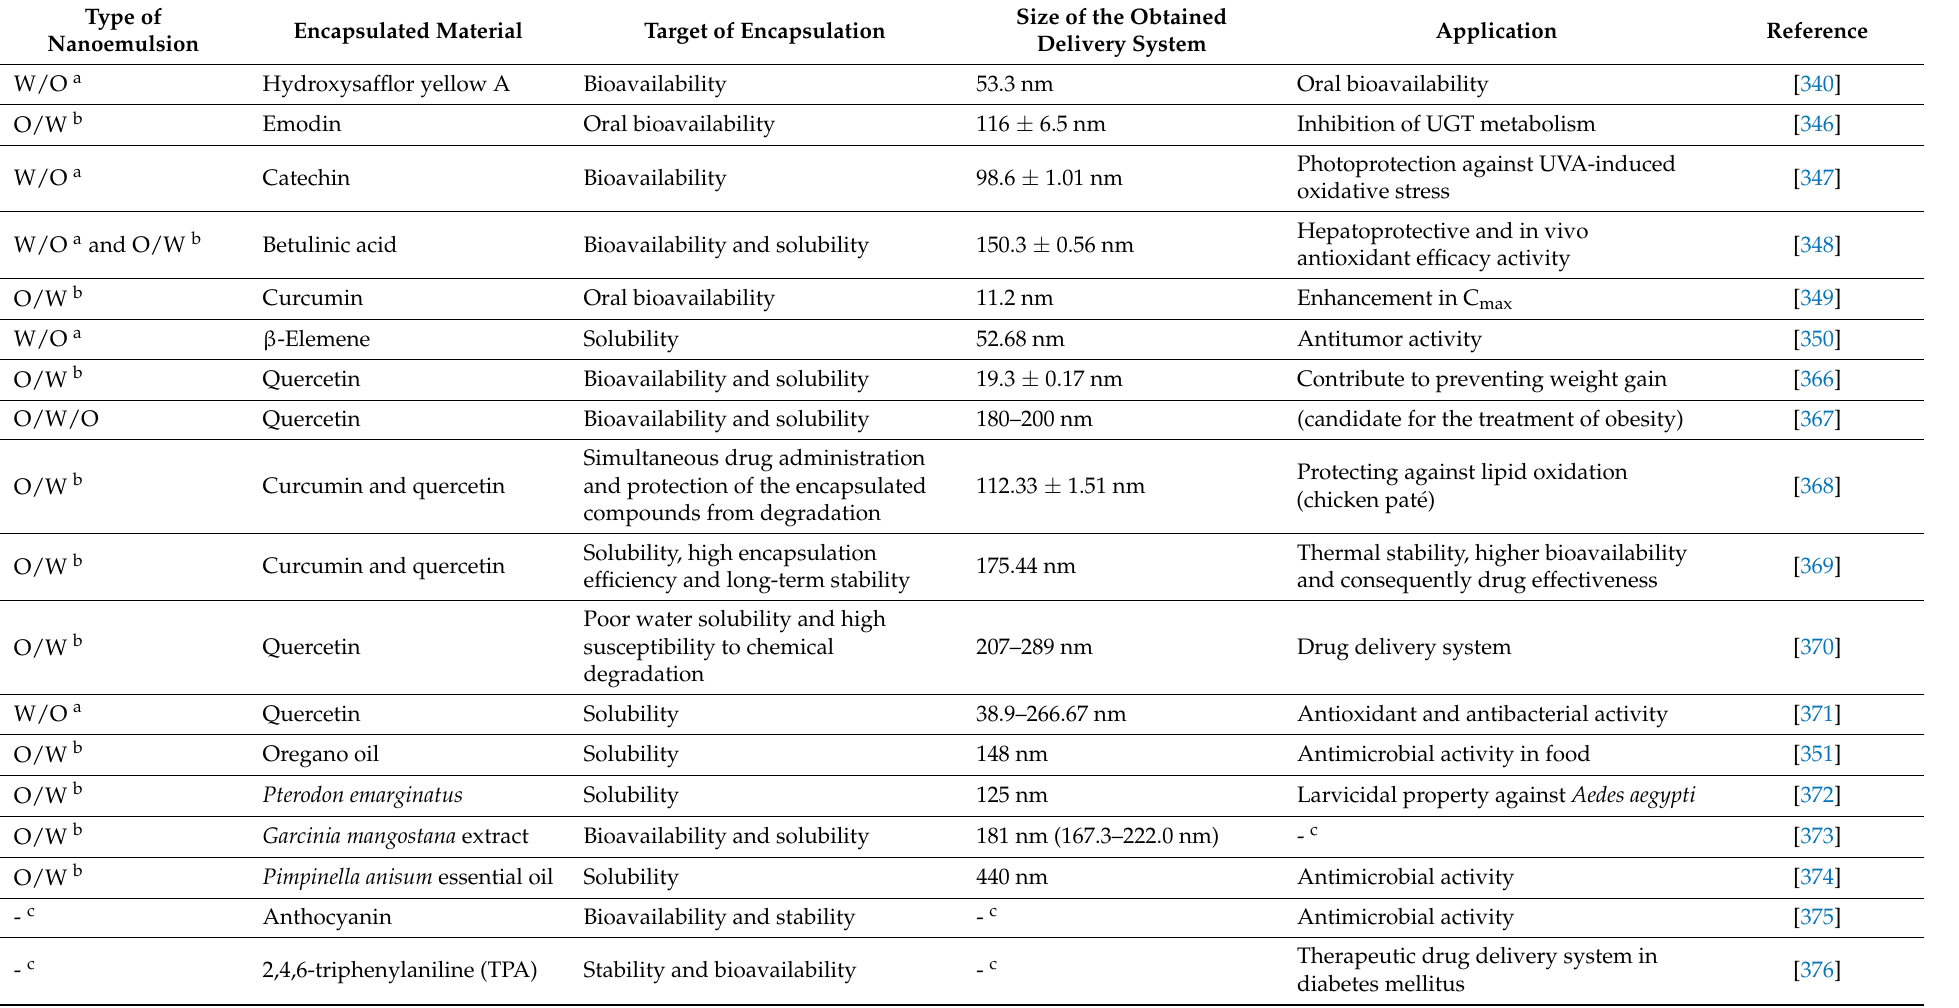
Table 4. Overview of different nanoemulsions that have been used for the encapsulation of various pure plant bioactive compounds, extracts and essential oils. Type